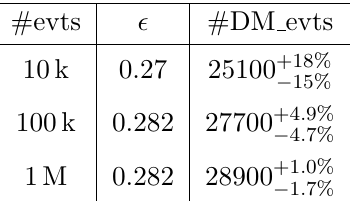
Table 5. Estimates of the total DM yields for increasing numbers of input events. The uncertain- ties refer to the variation around the 1D (cid:12)t error bars as explained in the main text. The number of input here does not include the geometrical acceptance (cid:15) , which is reported in the second